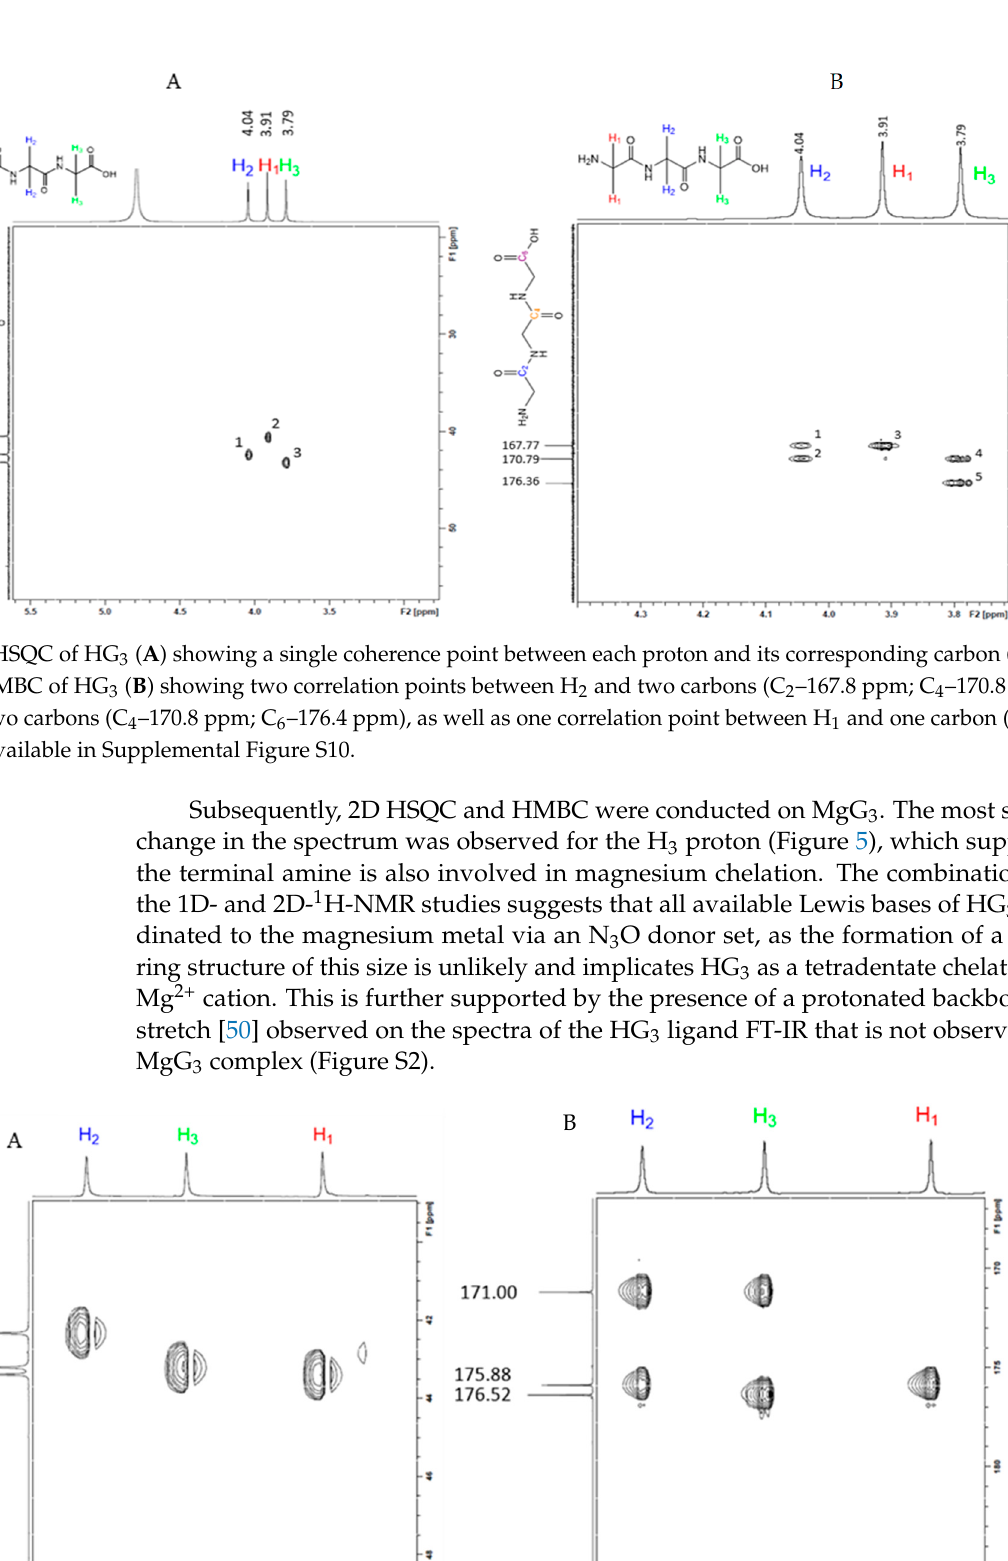
Figure 3 . 1 H-NMR of HG 3 in DMSO-d 6 ( A ) showing an observable split (J = 5.7 Hz) of the carbox- ylic acid proton due to participation in hydrogen bonding, and the 1 H-NMR of MgG 3 ( B ) no longer